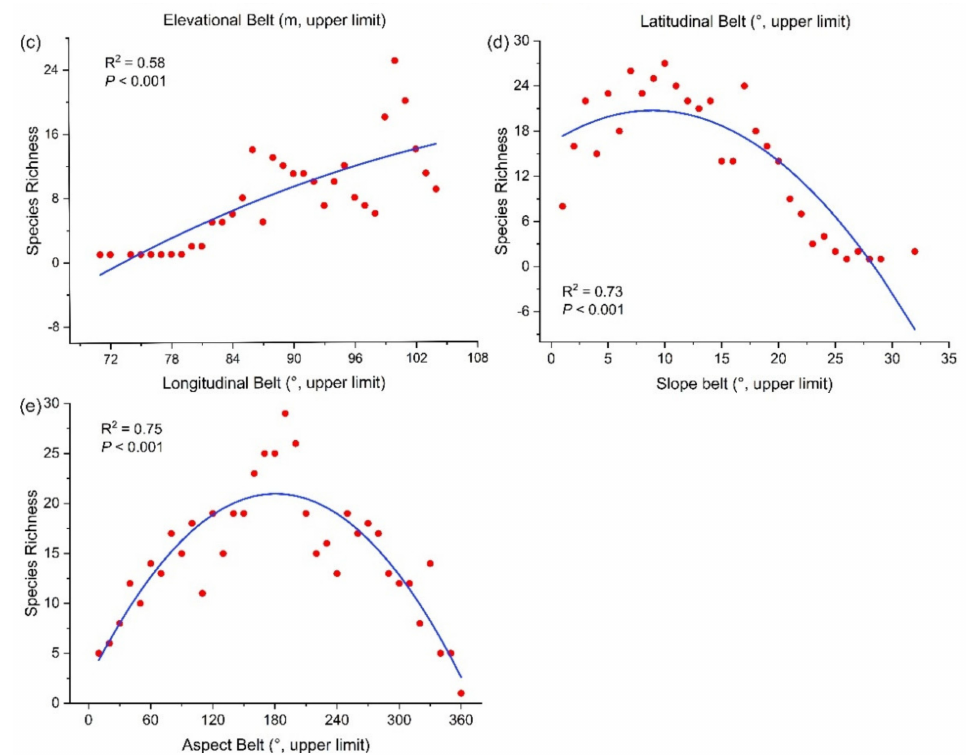
Figure 7. Species richness pattern of Meconopsis along the studied slope ( a ), latitudinal ( b ), longitudi- nal ( c ), elevational ( d ), and aspect ( e )